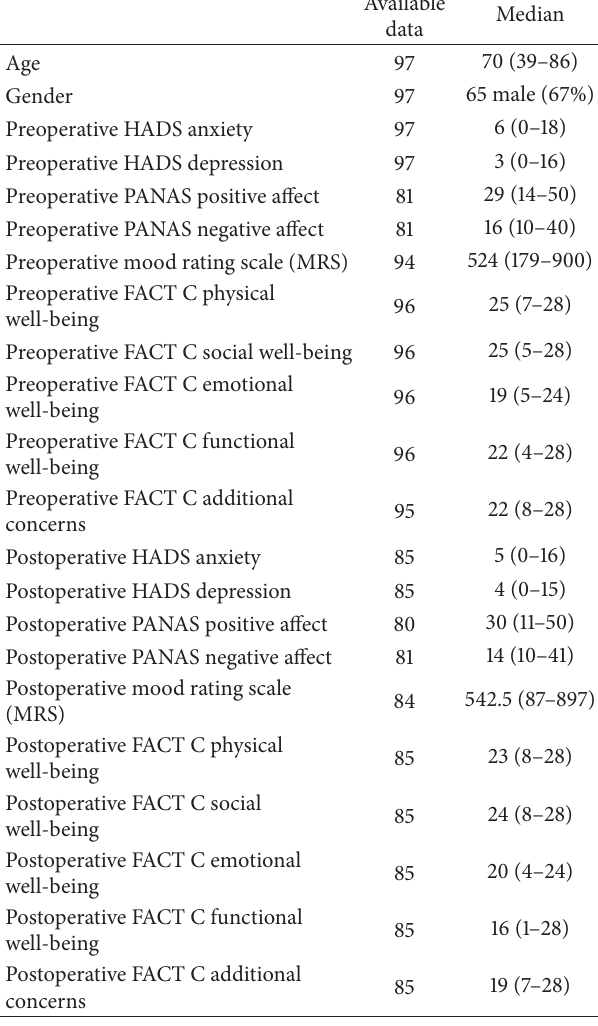
Table 1: Median scores of demographic and Qol measures. Table 2: Univariate analysis of demographic and staging factors and